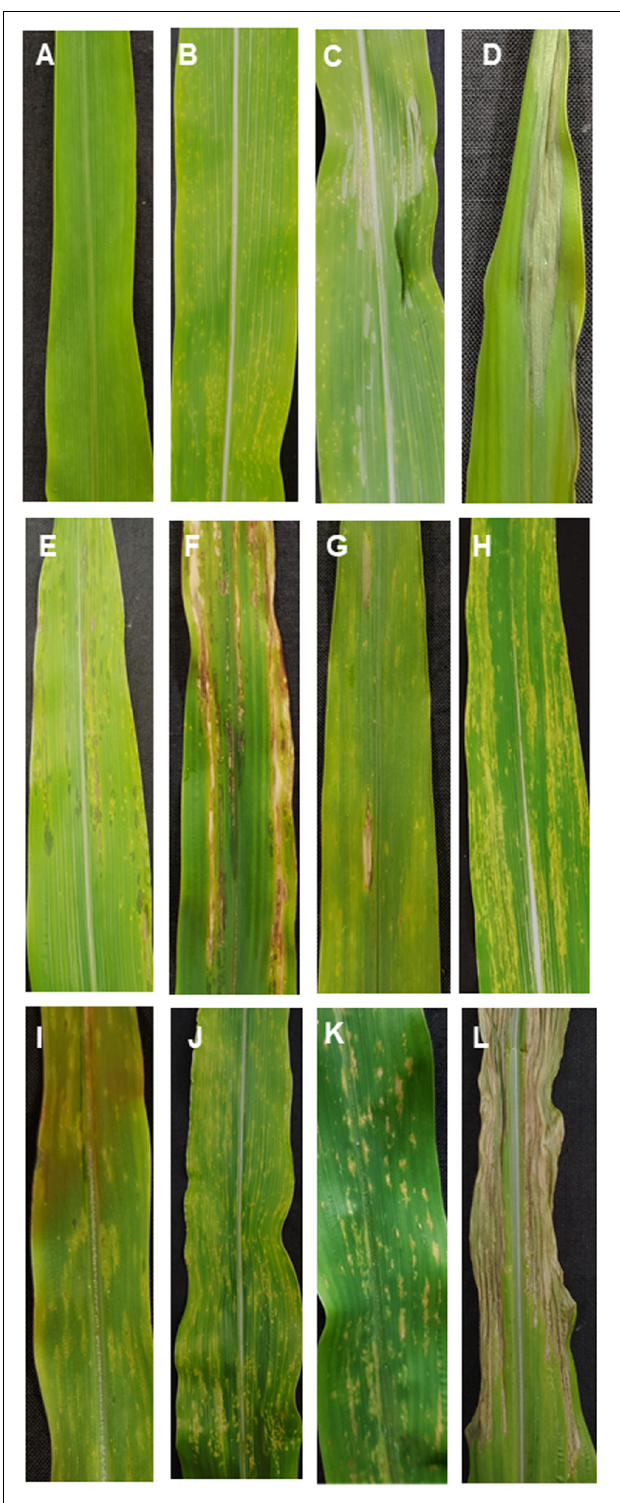
FIGURE 2 | Symptomology of Exserohilum turcicum leaf infection on maize differential lines B37 without resistance genes and with the resistance genes Ht1, Ht2, Ht3, and Htn1 . Symptom development in a compatible interaction